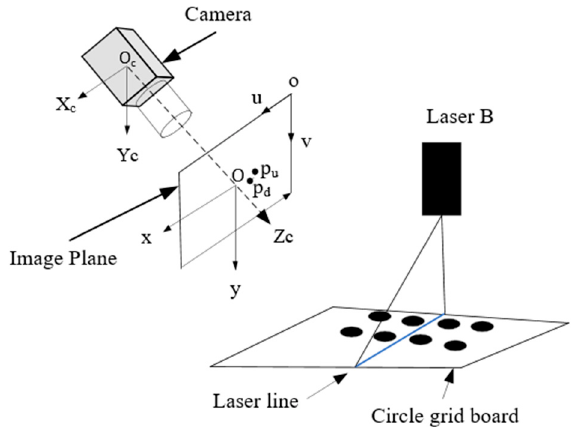
Figure 5. Schematic of the circle grid board used to extract the laser line plane.